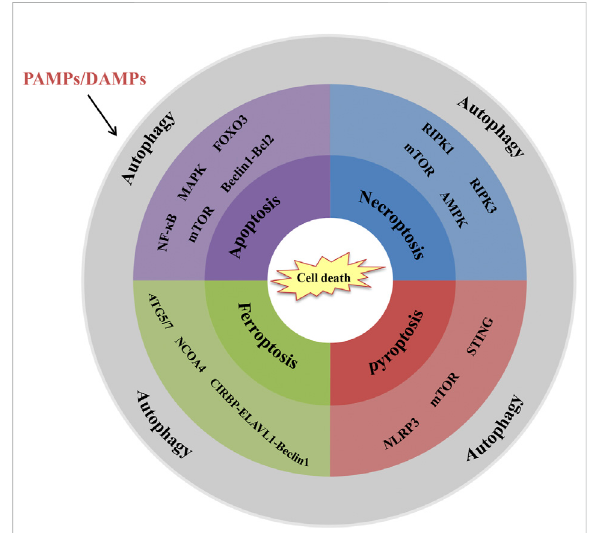
FIGURE 2 Interrelations between autophagy and cell death in organ transplantation.Schematicshowsthekeysignallingmoleculesand signalling pathways. (1) NF- κ B, MAPK, FOXO3, mTOR and Beclin- 1-Bcl2 are involved in autophagy-regulated apoptosis. (2) RIPK1, RIPK3. mTOR and AMPK are involved in autophagy- regulated necroptosis. (3) ATG5/7, NCOA4, and CIRBP-ELAVL1- Beclin-1 axis are involved in autophagy-regulated ferroptosis. (4) NLRP3, mTOR and STING are involved in autophagy-regulated